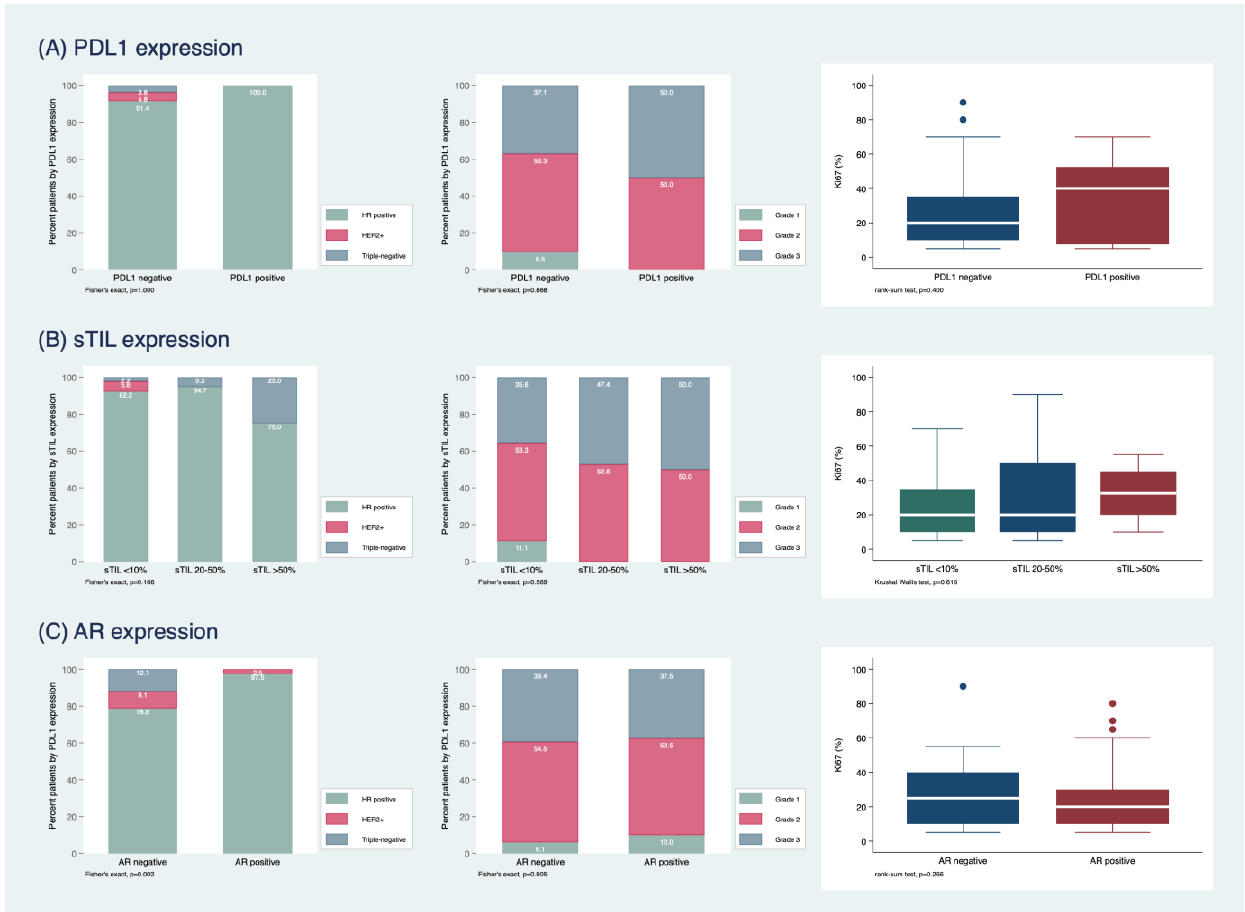
Figure 3. Associations between ( A ) PD-L1 ( A , B ) stromal TILs (sTILs) and ( C ) AR expression with breast cancer subtype, tumor grade and Ki67 index. Colored dots in the boxplot are outside values beyond the upper or lower whisker.